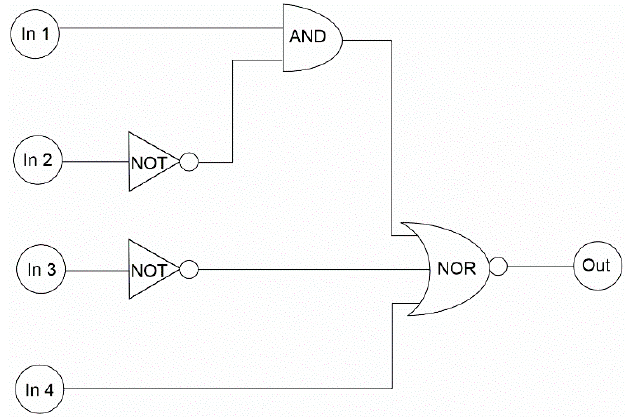
Figure 5. The logic circuit representing the Truth Table 1 (In 1 (UV), In 2 (Vis), In 3 (Zn 2+ ), In 4 (EDTA)).